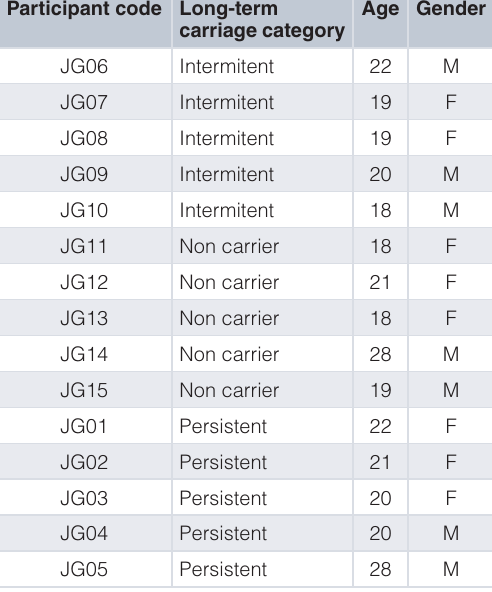
Table 1. Characteristics of participants of the microbiome